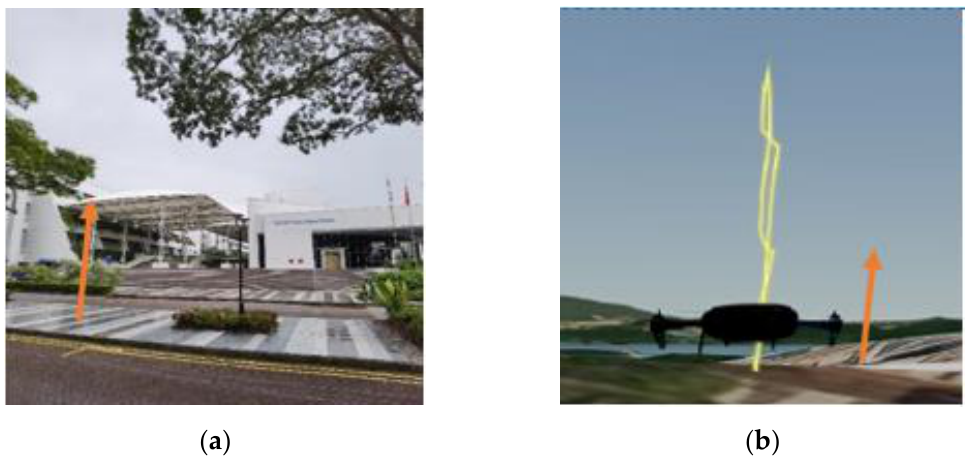
Figure 4. ( a ) Outside Admin Building, NTU ( b ) Hover Path at Admin Building.